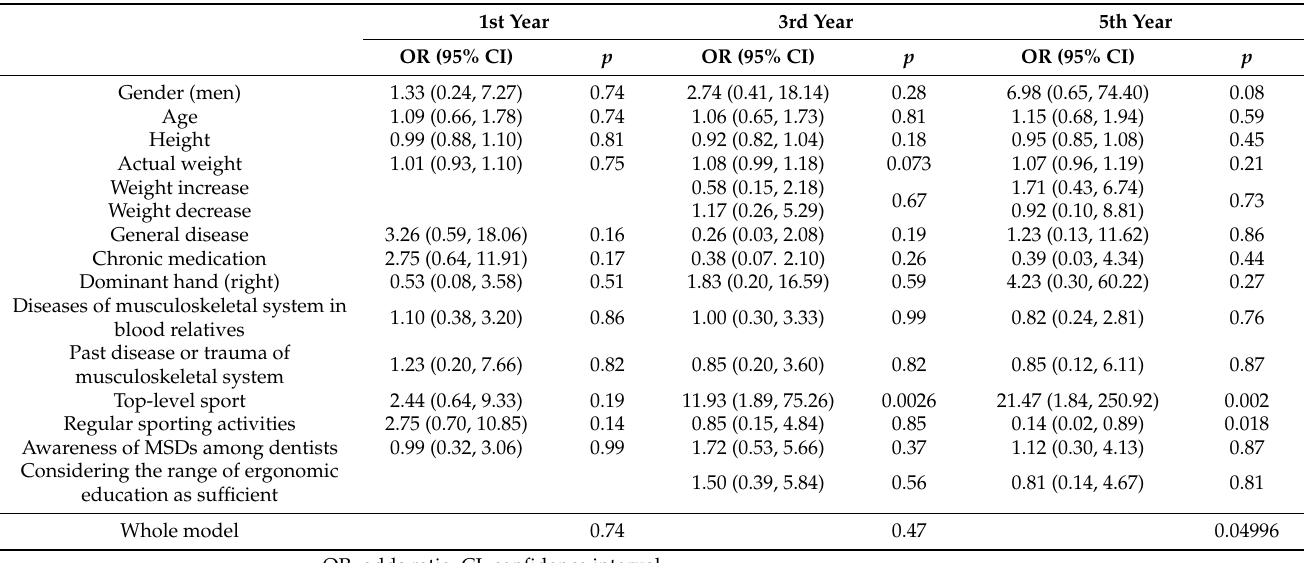
Table 4. The multivariate analysis of the influence of the followed factors on the occurrence of neck pain.